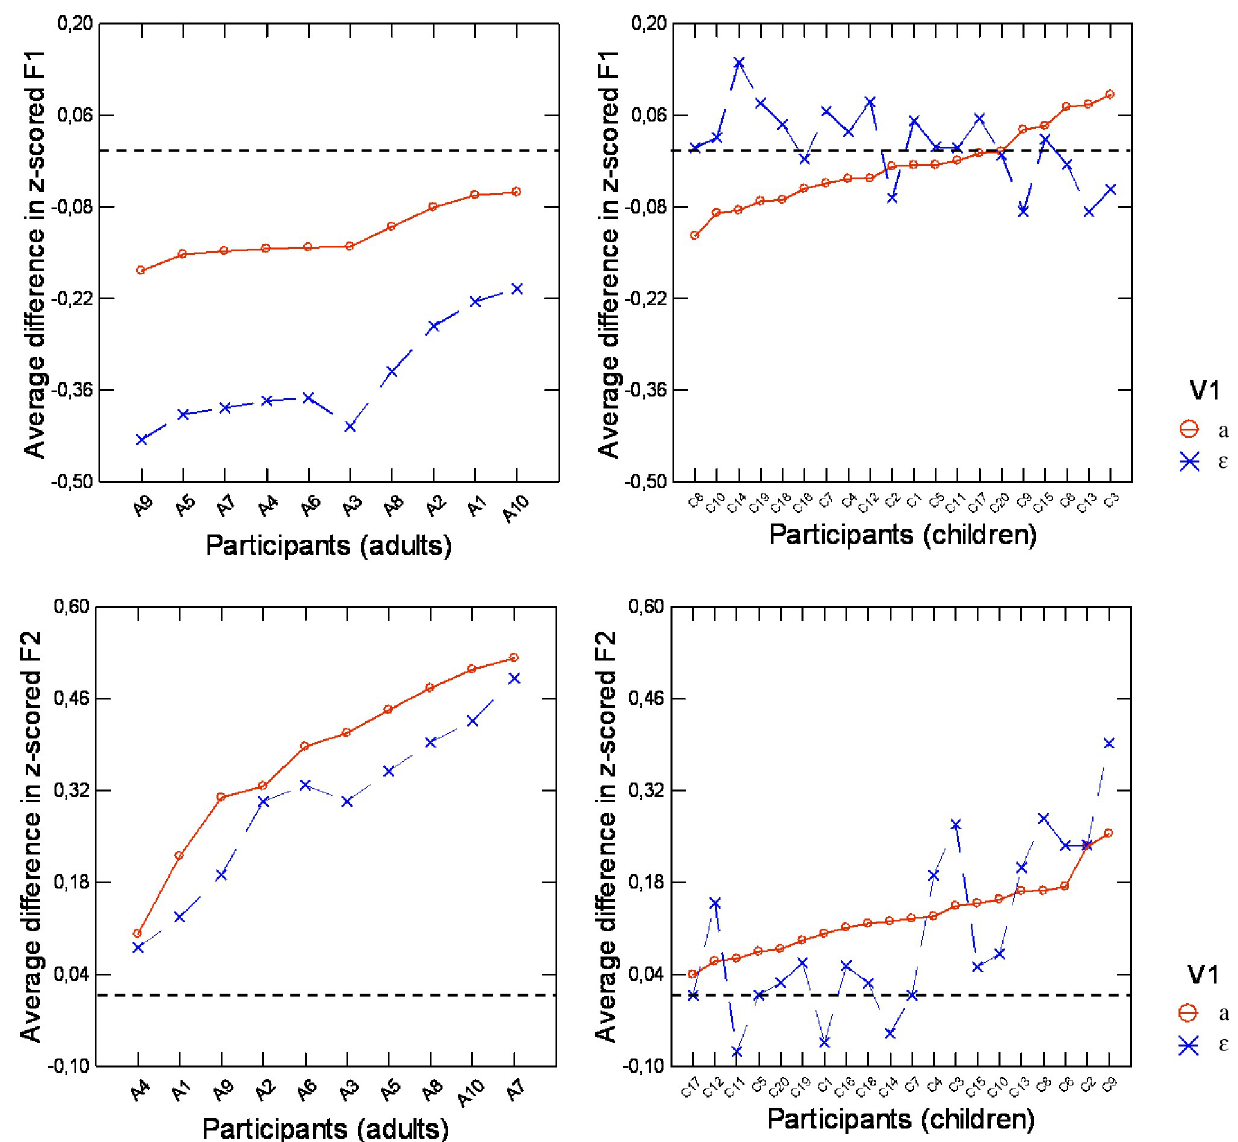
Fig 8. Average difference in z-scored F1 and z-scored F2 in V 1 between V 1 C/i/ and V 1 C/a/, per participant. The solid line corresponds to /a/CV 2 sequences and the dashed line corresponds to / ε /CV 2 sequences. In each panel the horizontal dotted line indicates zero difference. In the upper panels anticipation corresponds to negative differences. In the lower panels anticipation corresponds to positive